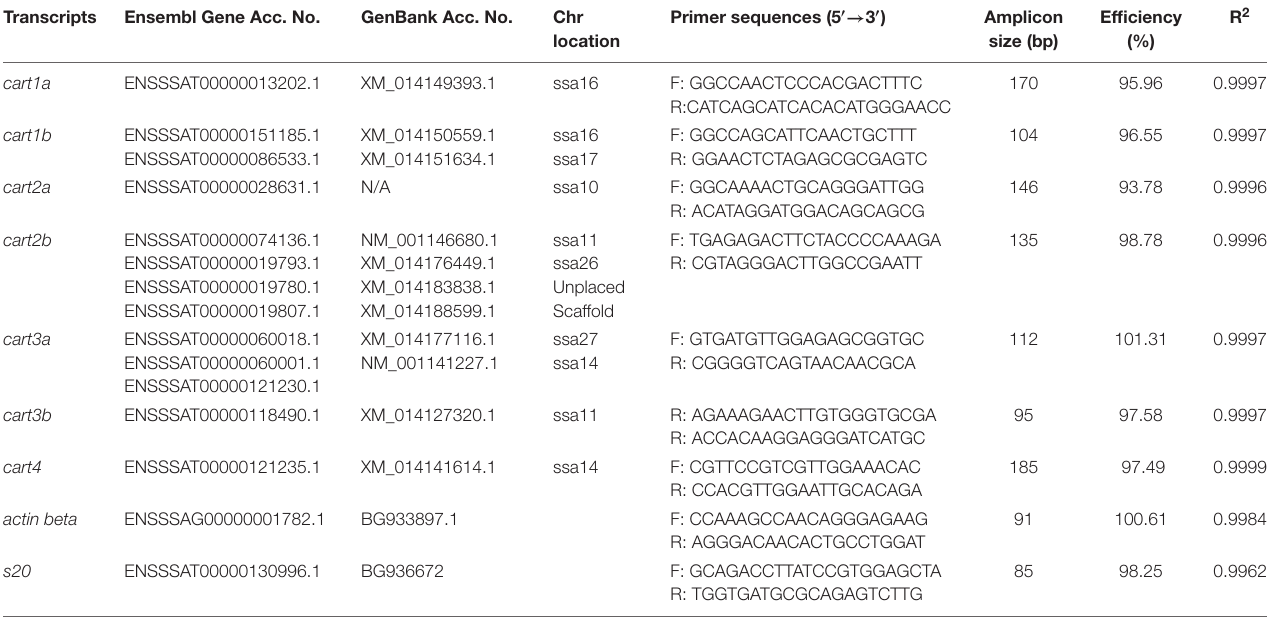
TABLE 1 | Sequence of specific primers used for reverse transcriptase quantitative PCR (RT-qPCR) analyses. Transcripts Ensembl Gene Acc. No. GenBank Acc. No. Chr